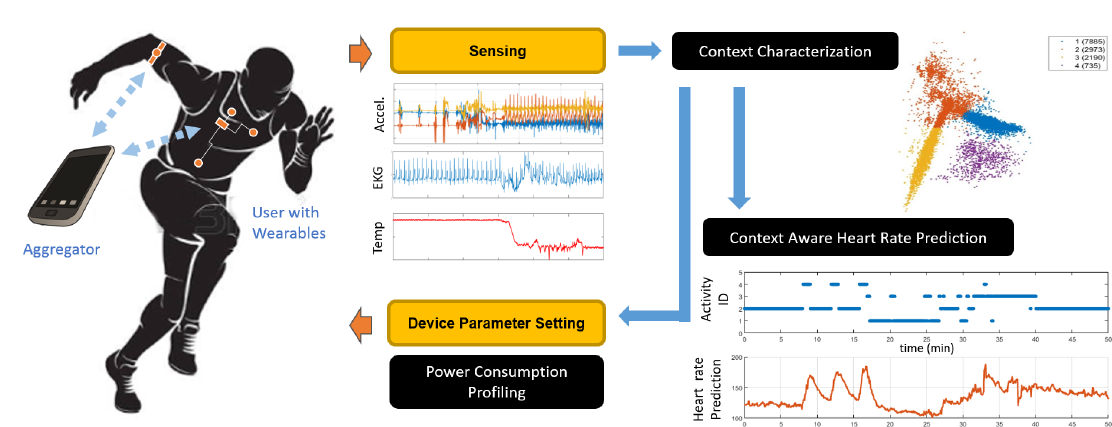
Figure 1. Overview of the proposed pipeline for sensor selection and activity aware prediction. Multimodal sensor information is sensed by the wearable system and transmitted to an aggregator for fusion and prediction. Context information is used for physiological response prediction and sensor selection by disabling certain modalities, and hence reduce power